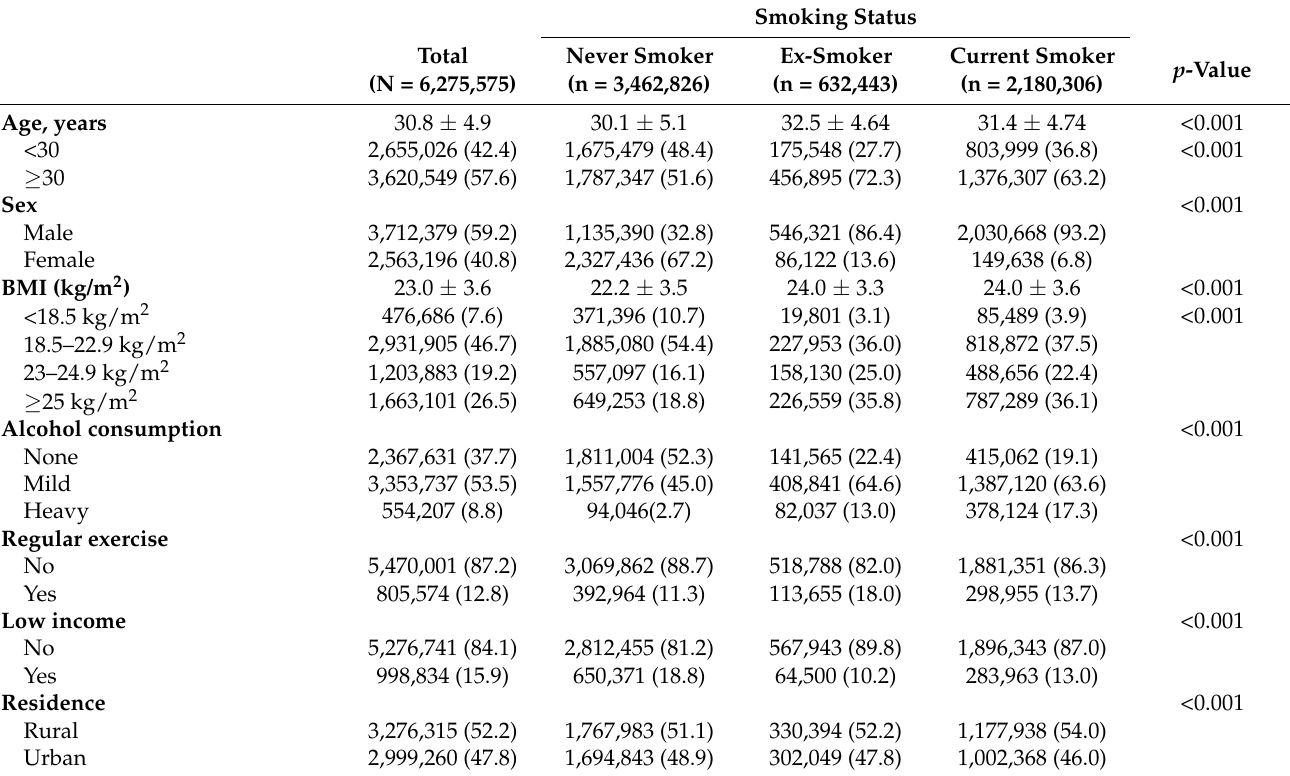
Table 1. Baseline characteristics of the study population according to smoking